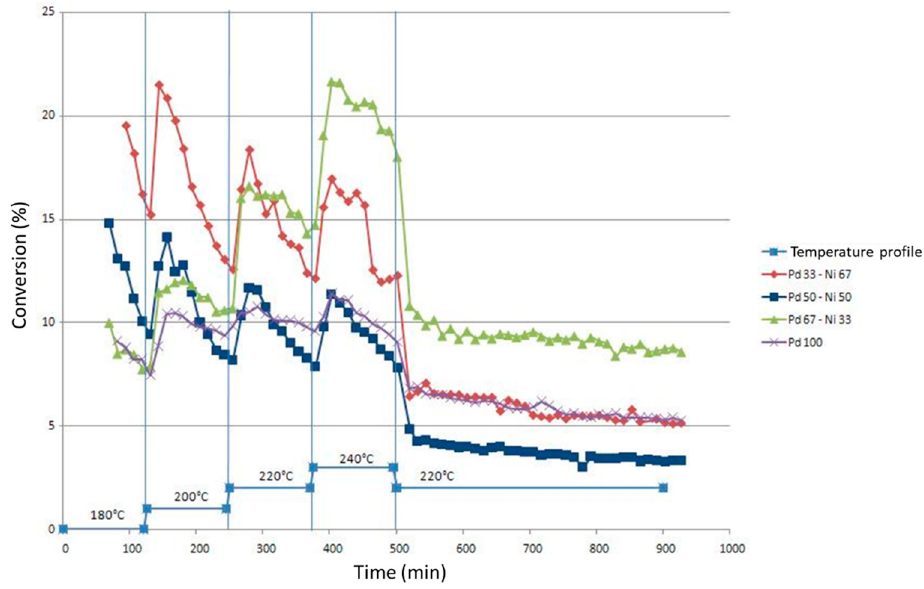
Figure 5. Comparison of the conversions of chlorobenzene to benzene as a function of time for the Pd-Ni/SiO 2 series. Table 3. Mean chlorobenzene conversion at 220 °C.